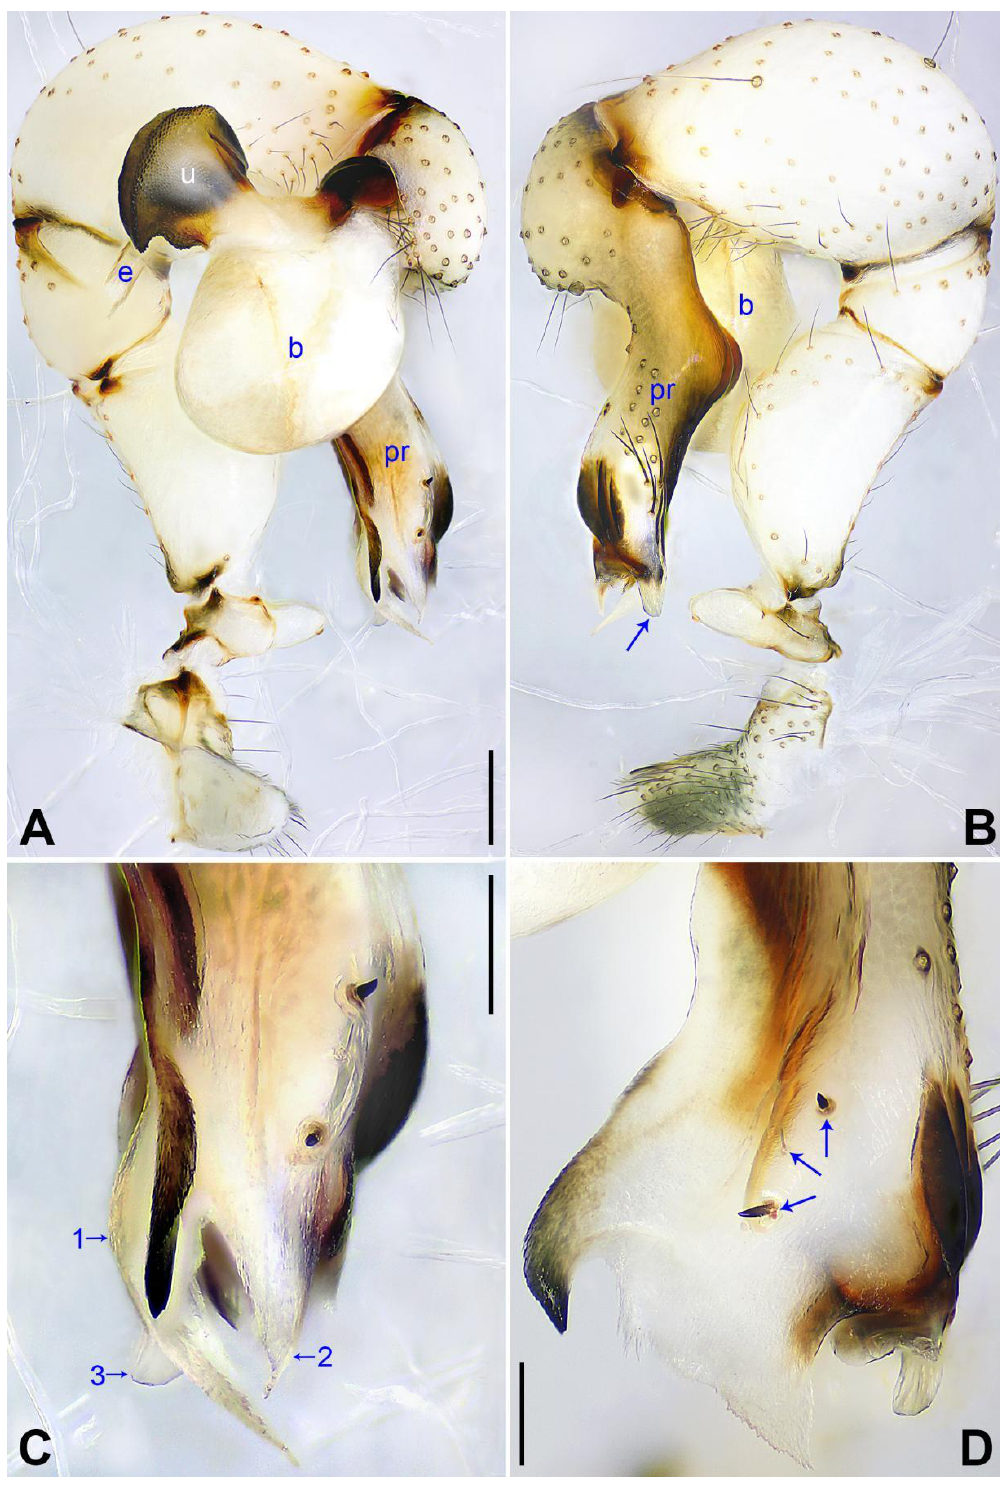
Figure 5. Pholcus linfen sp. nov., holotype male: ( A ) pedipalp, prolateral view; ( B ) pedipalp, retrolateral view (arrow points at ventro–distal apophysis); ( C ) distal part of procursus, prolateral view (arrow 1 points at prolateral membranous process, arrow 2 points at dorsal membranous lamella, arrow 3 points at ventro–distal apophysis); ( D ) distal part of procursus, dorsal view (arrows point at dorsal spines). B = bulb, e = embolus, pr = procursus, u = uncus. Scale bars: ( A , B ) = 0.20 mm; ( C , D ) = 0.10 mm.